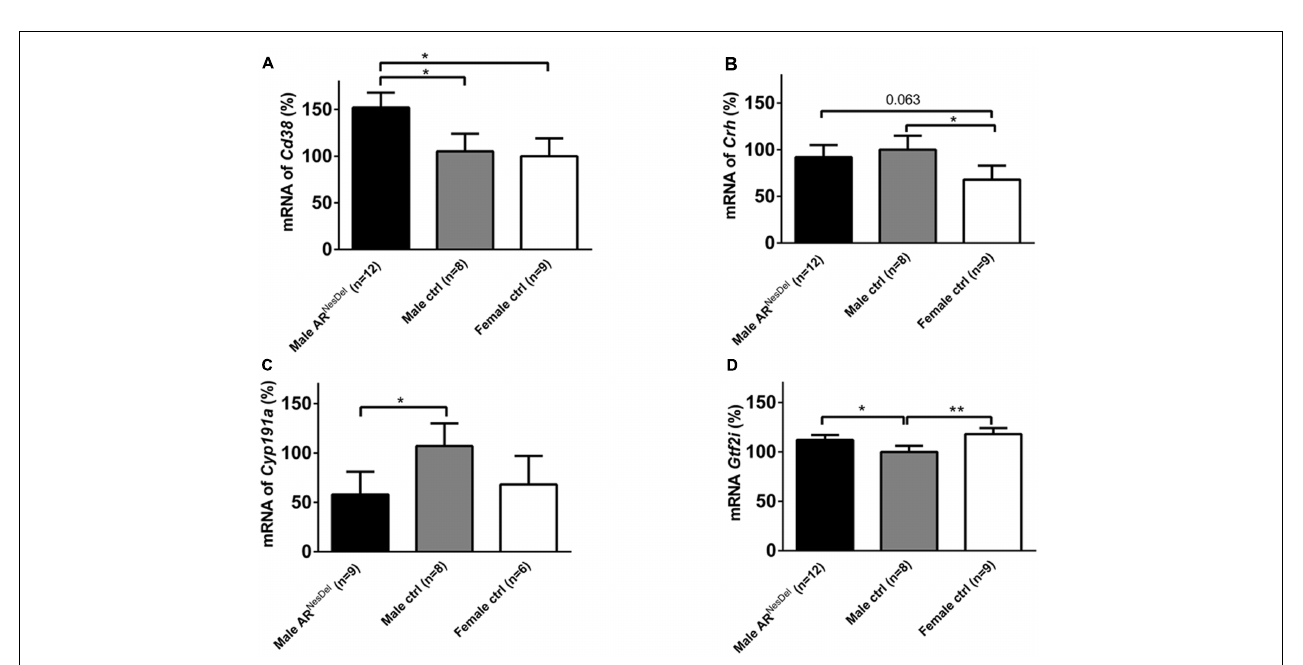
FIGURE 7 | mRNA expression levels of (A) Cd38 (B) Cyp19a1 (C) Oxtr (D) Ucn3, and (E) Esr1 in the hypothalamus of male AR NesDel , as well as in male (wildtype, AR flox , NesCre + / − ) and female (wildtype, ARflox + / − ) controls. The results are presented as percent ( ± SEM) in relation to the male control group. ∗ p < 0.05, ∗∗ p < 0.01.